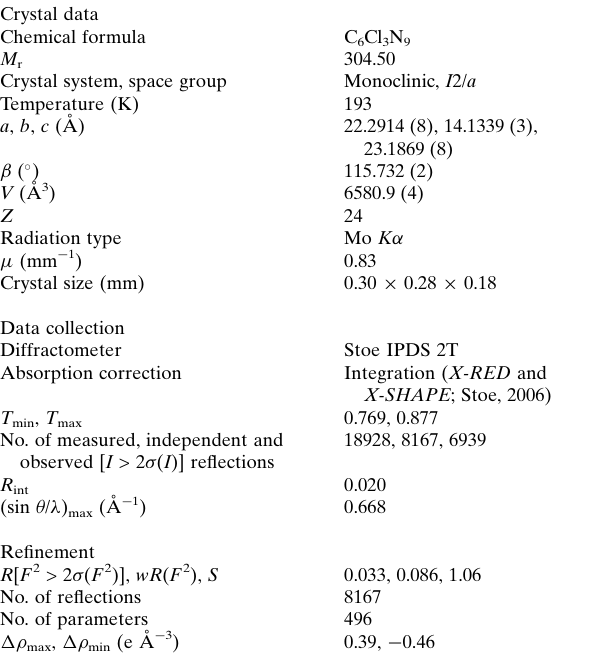
Table 1 Experimental details. Crystal data Chemical formula